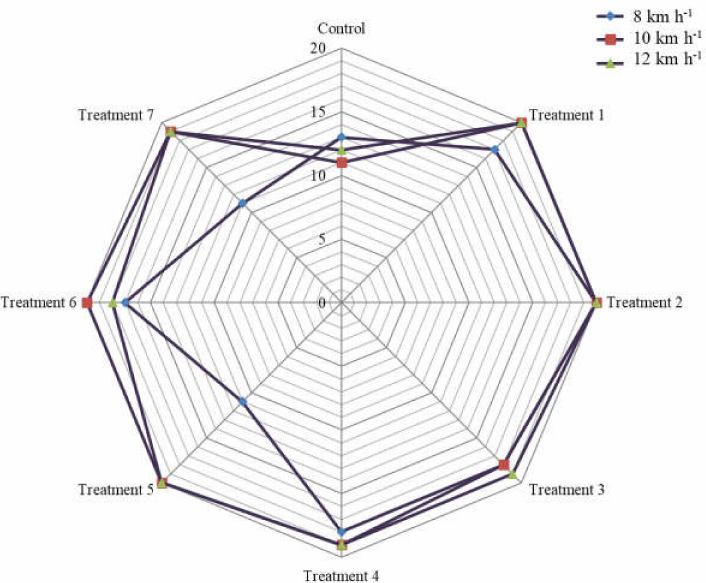
Figure 6. Decrease in the traction force of the shallow tillage machine (%) in different treatments in 2017 compared to the more humid year 2016: Treatment 1—composition of Table 1. Treatment 2—No. 1 and No. 2 mixture; Treatment 3—composition of the biopreparation No. 2; Treatment 4—No. 1 and No. 3 mixture; Treatment 5—composition of the biopreparation No. 4; Treatment 6—No. 1 and No.